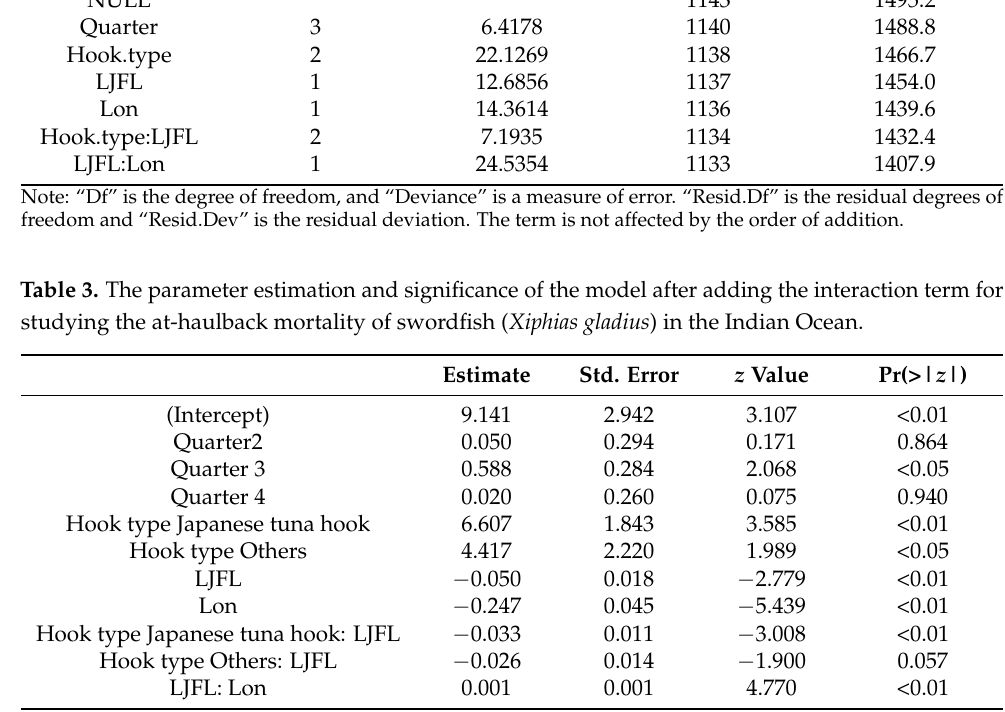
Table 2. The deviation explanation after adding the interaction terms to the generalized linear model of the at-haulback mortality of swordfish ( Xiphias gladius ) in the Indian Ocean. df Deviance Resid.Df Resid.Dev NULL 1143 1495.2 Quarter 3